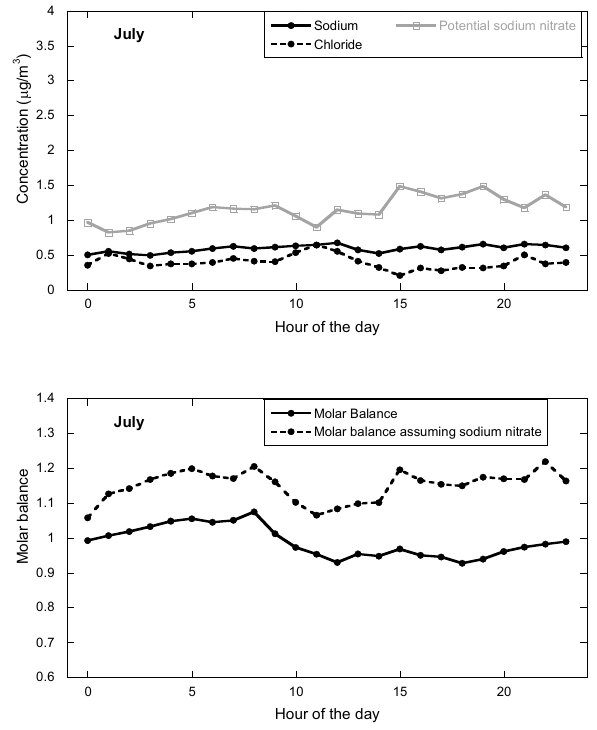
Figure 8. a) Measured diurnal cycle of sodium and chloride concentrations as well as that of the potential sodium nitrate concentration during July at Cabauw. The potential sodium nitrate was calculated under assumption that all sodium derives from sea salt and all chloride depletion is caused by reaction with nitric acid; b) observed diurnal cycle of the molar balance between ammonium and the sum of nitrate and sulfate and the change in the balance by assuming the potential sodium nitrate (see main text).